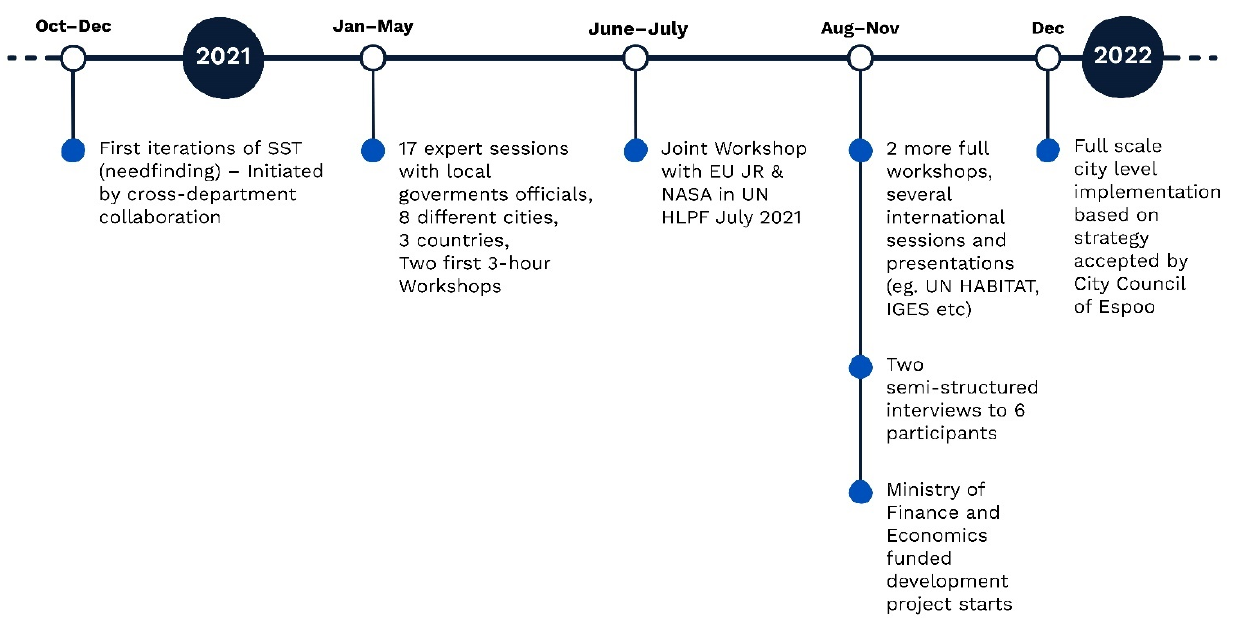
Figure 1. Timeline of SST development process.